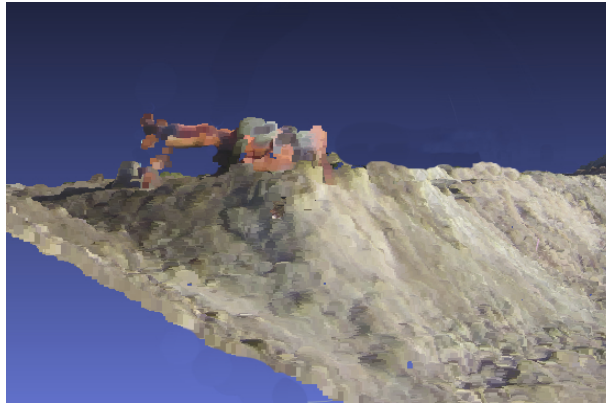
Figure 6. 3D model of the object to